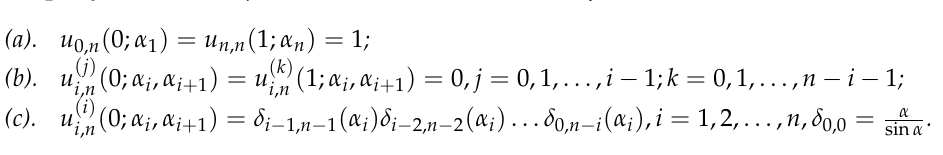
, α 3 = π 8 , α 3 = 13 π 8